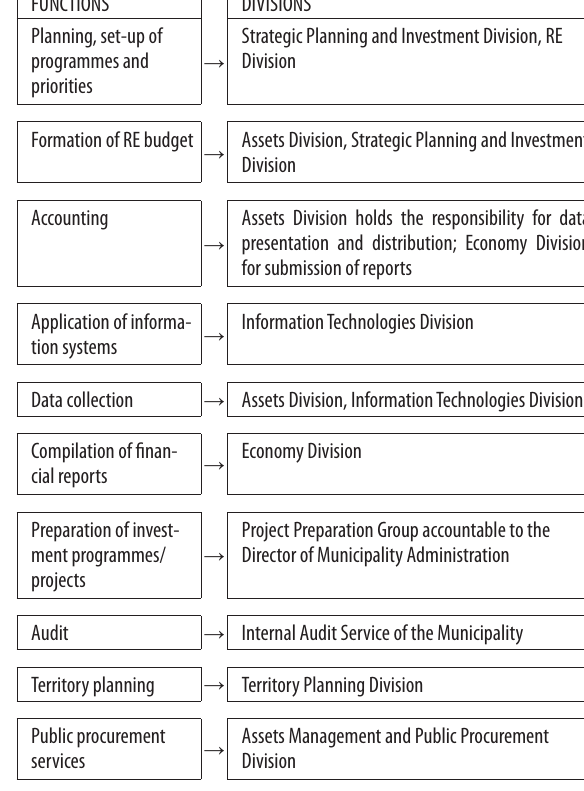
Fig 2. RE management functions on the municipal level